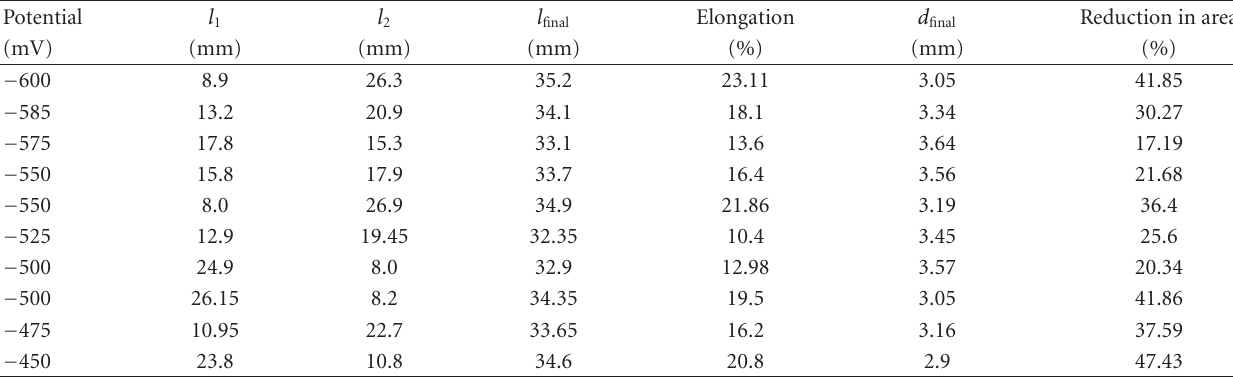
Table 5: Potential-dependent results of samples tested in 25% CO–75% CO 2 at 45 ◦ C.